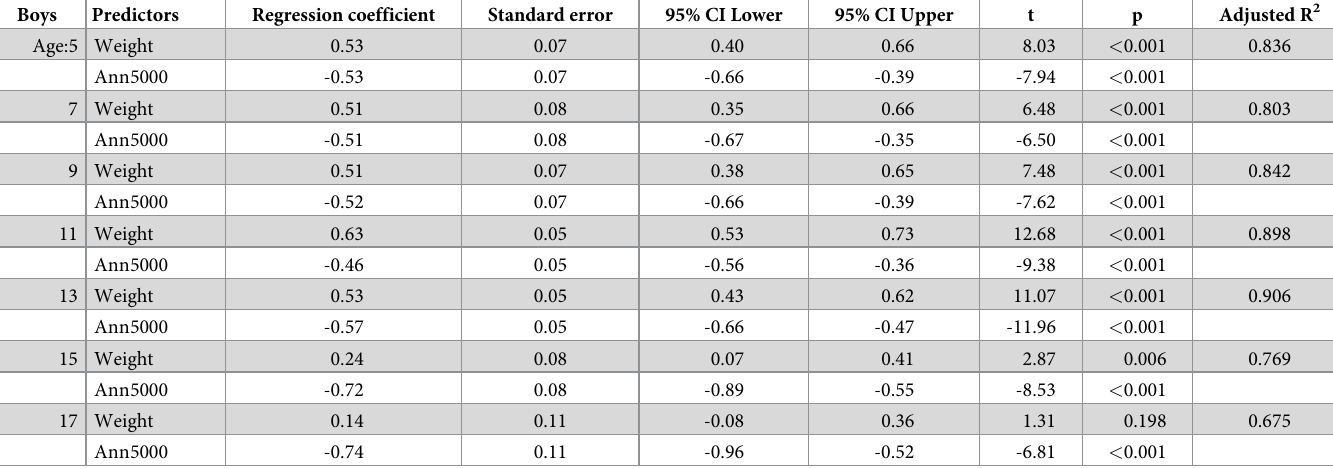
Table 4. Regression coefficients (standard errors) of predictors of height (boys).